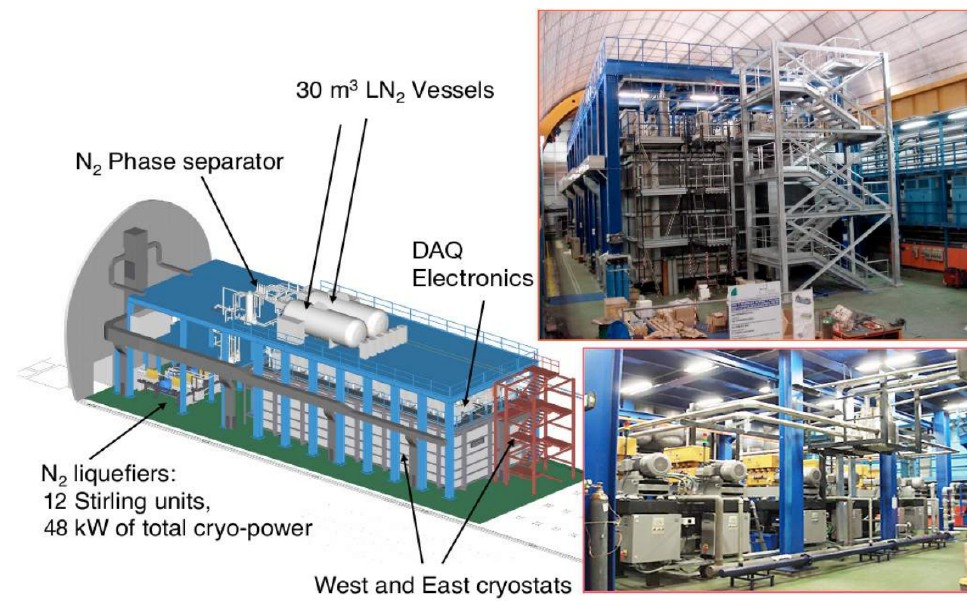
Figure 8. ( Left ): Schematic view of the whole ICARUS T600 plant in Hall B at LNGS. ( Right-top ): Detector plant. ( Right-bottom ): Details of the cryo-cooler